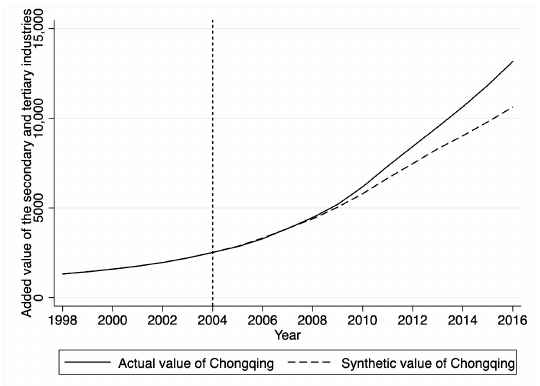
Figure 10. Placebo test result of synthetic control supposing LQT program implemented from 2004.